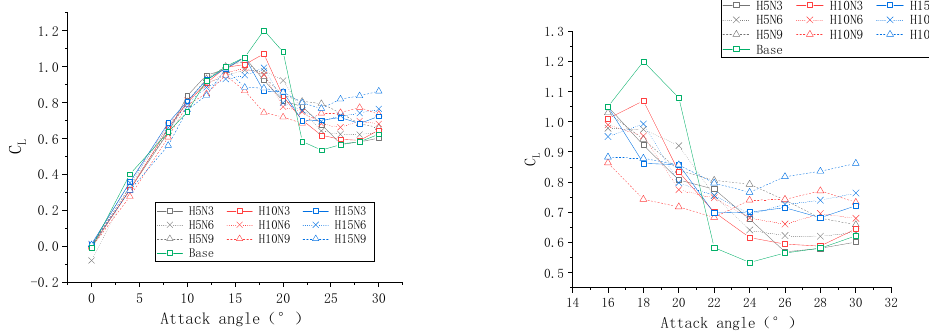
Figure 7. Comparison of lift coefficients between the base blade and blades with tubercles.